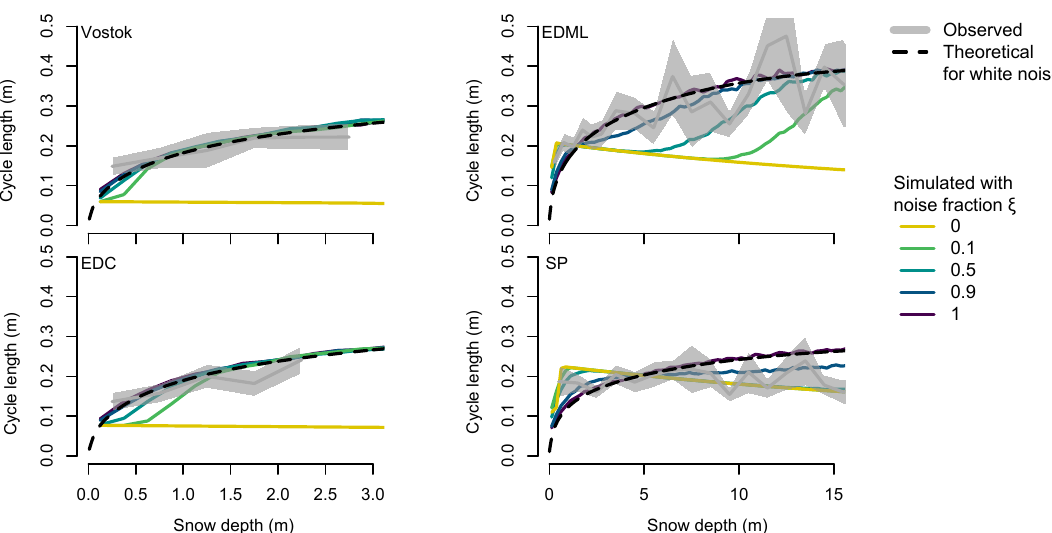
Figure 7. Comparison of numerically predicted and observed δ 18 O cycle statistics as a function of depth for all sites with multiple profiles. Observed cycle lengths (grey line) and a 2 standard error estimation uncertainty (grey band) are shown. Simulated cycle lengths are shown for various noise fractions in the input signal (coloured lines). In addition, the theoretical cycle length for pure white noise is shown (dashed